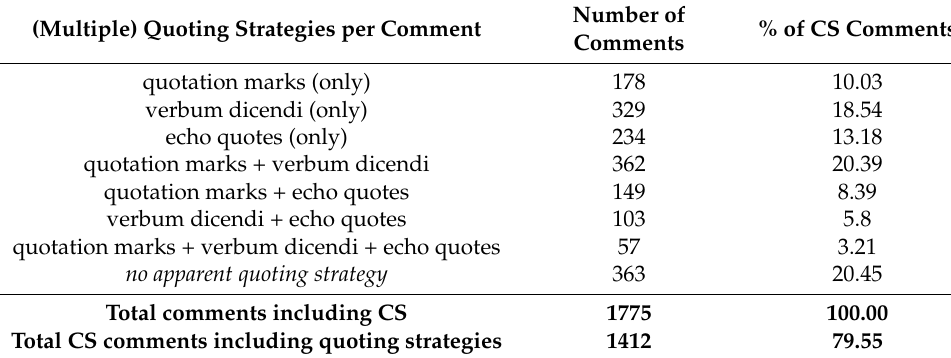
Table 4. Distribution of Quoting Strategies across Code-Switched